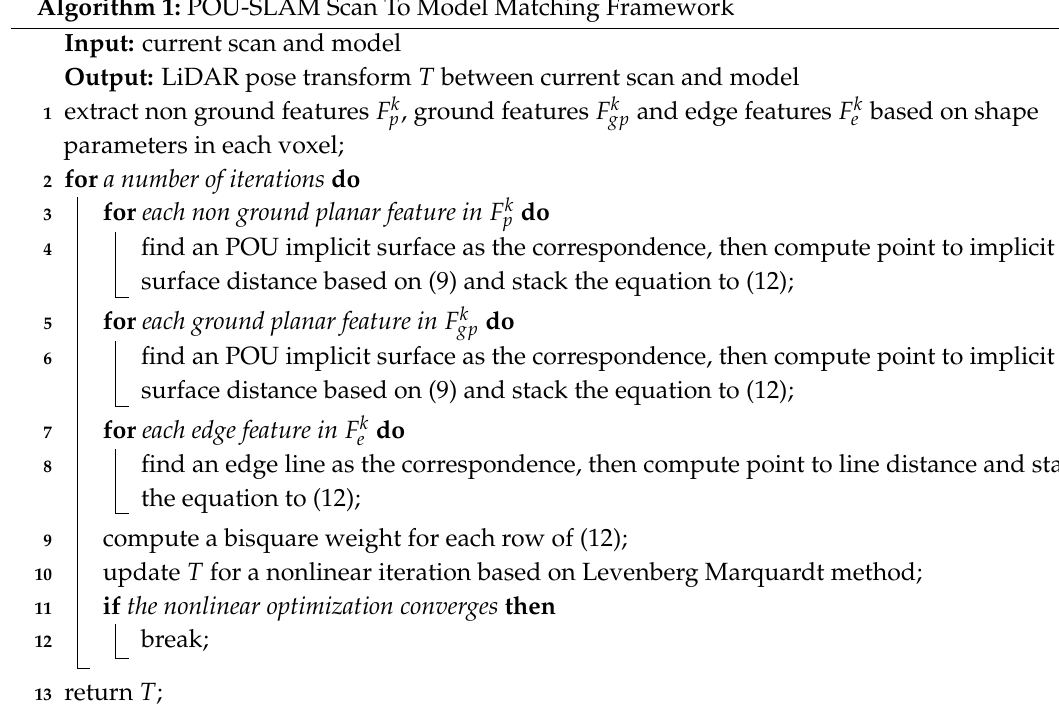
Algorithm 1: POU-SLAM Scan To Model Matching